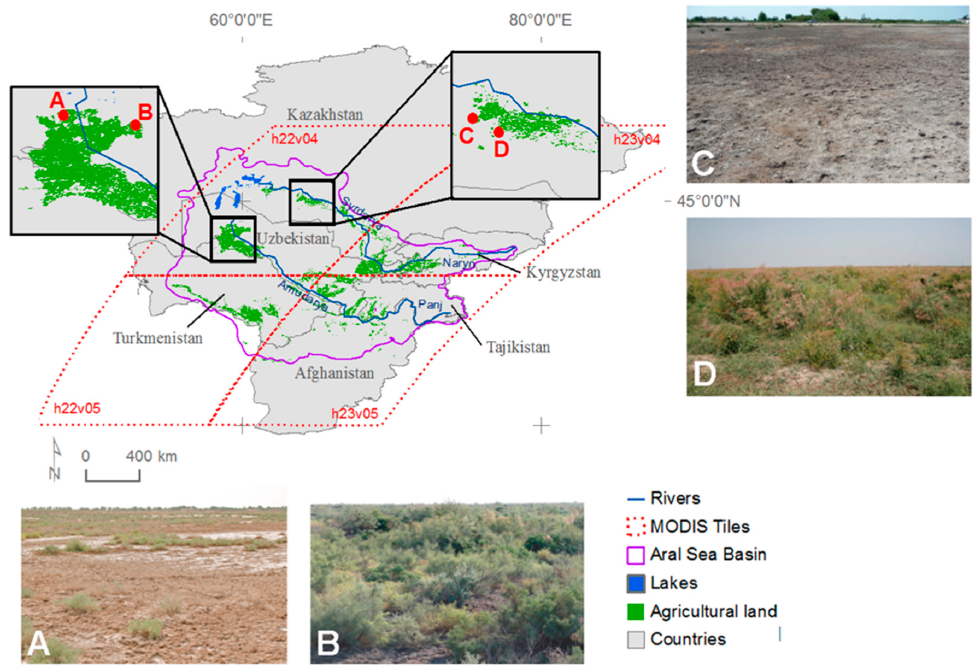
Figure 1. Drylands in the Aral Sea Basin and its irrigated agricultural land. The photographs from 2011 highlight examples of abandoned fields: open ( A ) and dense ( B ) shrubland in Karakalpakstan, bare soil ( C ) and dense shrubland mixed with herbaceous vegetation ( D ) in Kyzyl-Orda, Kazakhstan.